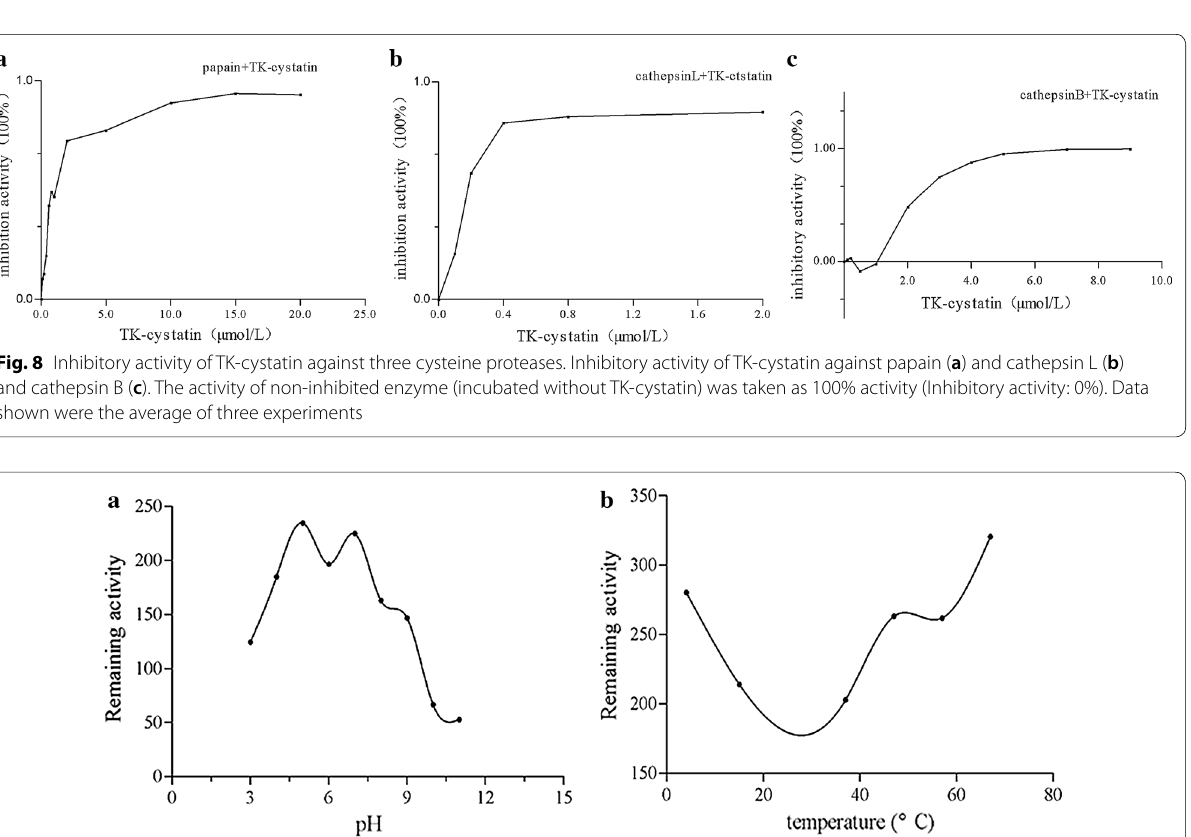
Fig. 9 pH and thermal stability of TK-cystatin. TK-cystatin incubated at different pHs or temperatures for 1 h and assayed for residual inhibitor activity against papain at standard conditions. Data shown were the average of three